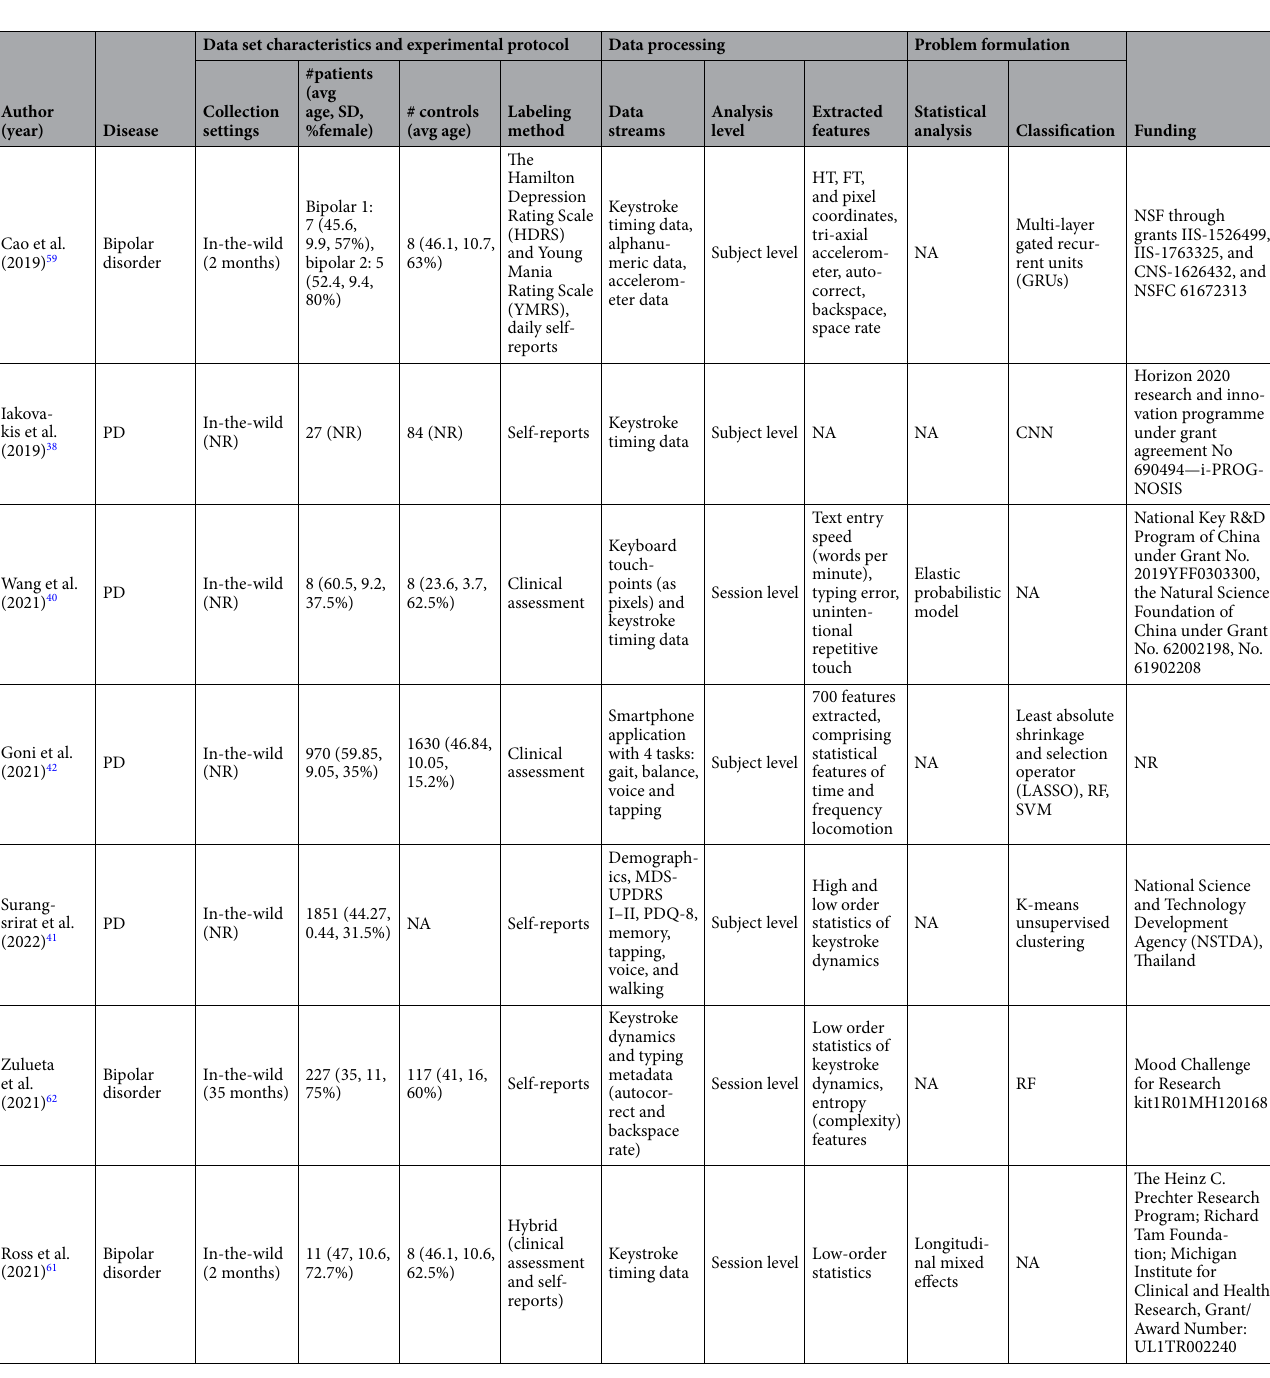
Table 1. Characteristics of included studies. NR—not reported; NA—not